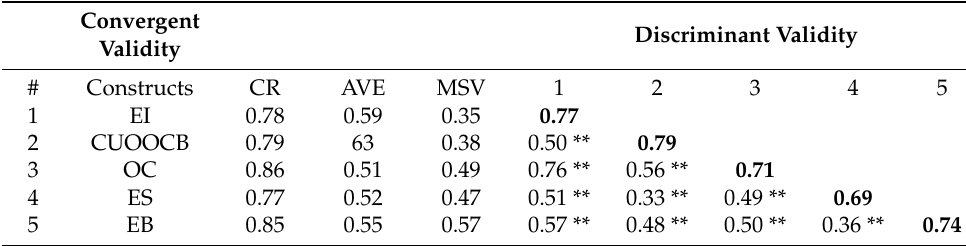
Table 4. Convergent and discriminant validity.